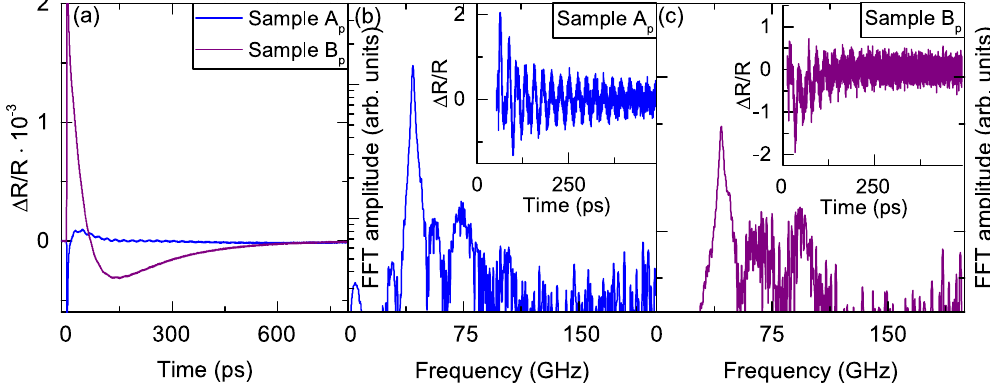
Figure 2. ( a ) Time-resolved reflectivity change of both planar samples A (blue) and B (purple). ( b ) FFT spectrum of the planar MBE grown bilayer (unrolled sample A as in the left part of Fig. 1). The inset shows the extracted time-resolved reflectivity change. ( c ) FFT spectrum of the planar MBE grown layers with an additional layer of